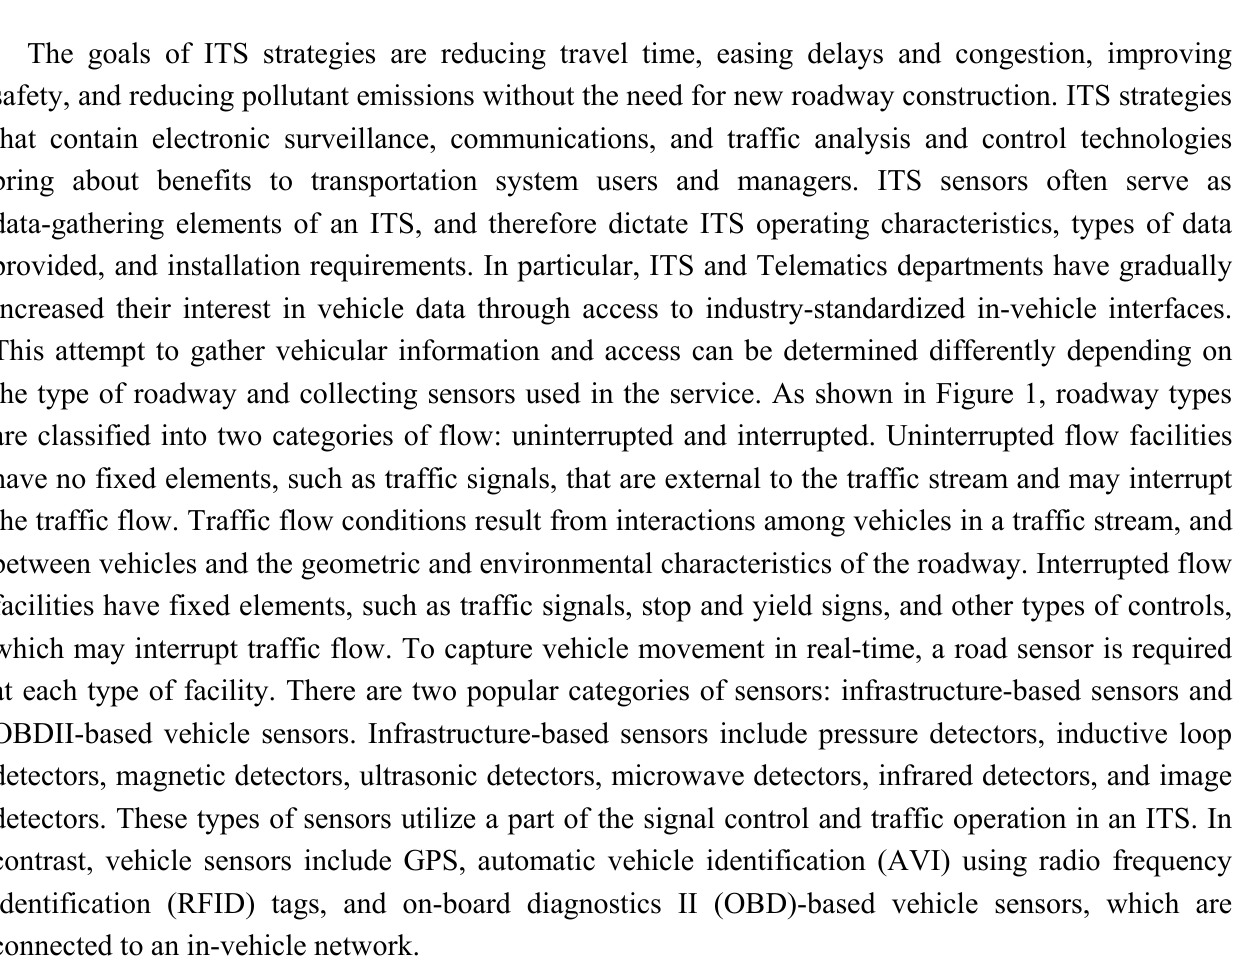
Figure 1. Roadway system and ITS